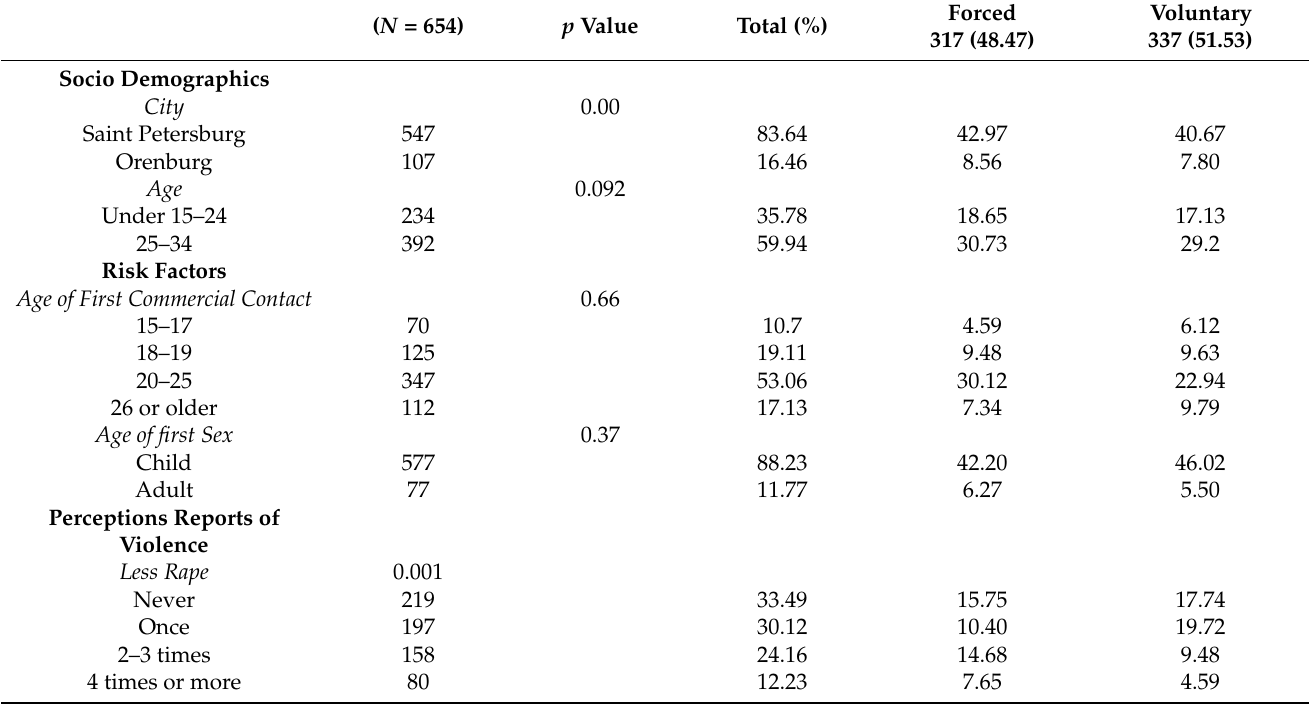
Table 1. Characteristics of women in the commercial sex trade in St. Petersburg and Orenburg, Russia, and their bivariate associations with voluntary vs. forced appraisal of entering the commercial sex trade ( N =